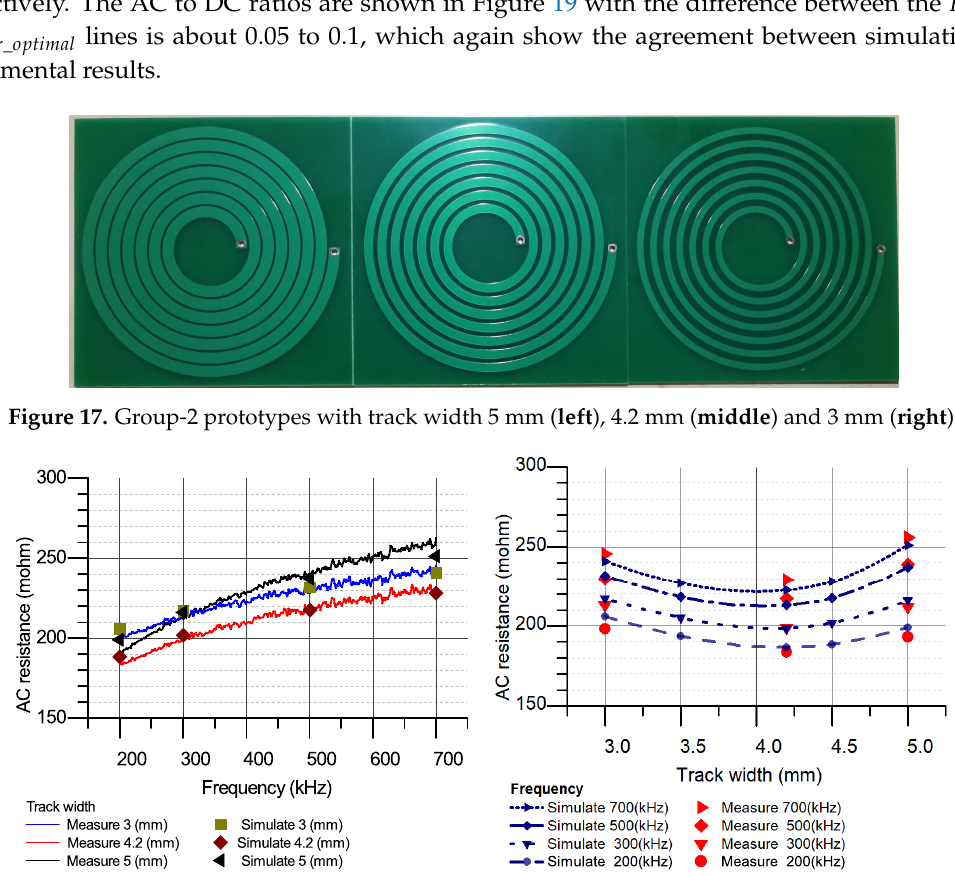
Figure 18. Group-2 measured and simulated AC resistances with changing in frequency ( left ) and track width ( right ).